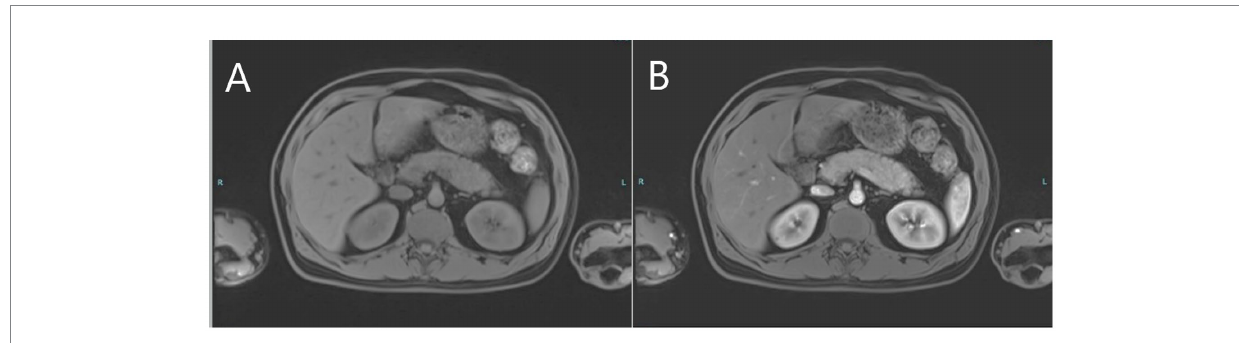
FIGURE 3 MRI images of the upper abdomen depicting pre-contrast bulky pancreas (A) and post-contrast delayed diffuse homogenous enhancement of the pancreas (B) consistent with autoimmune pancreatitis.